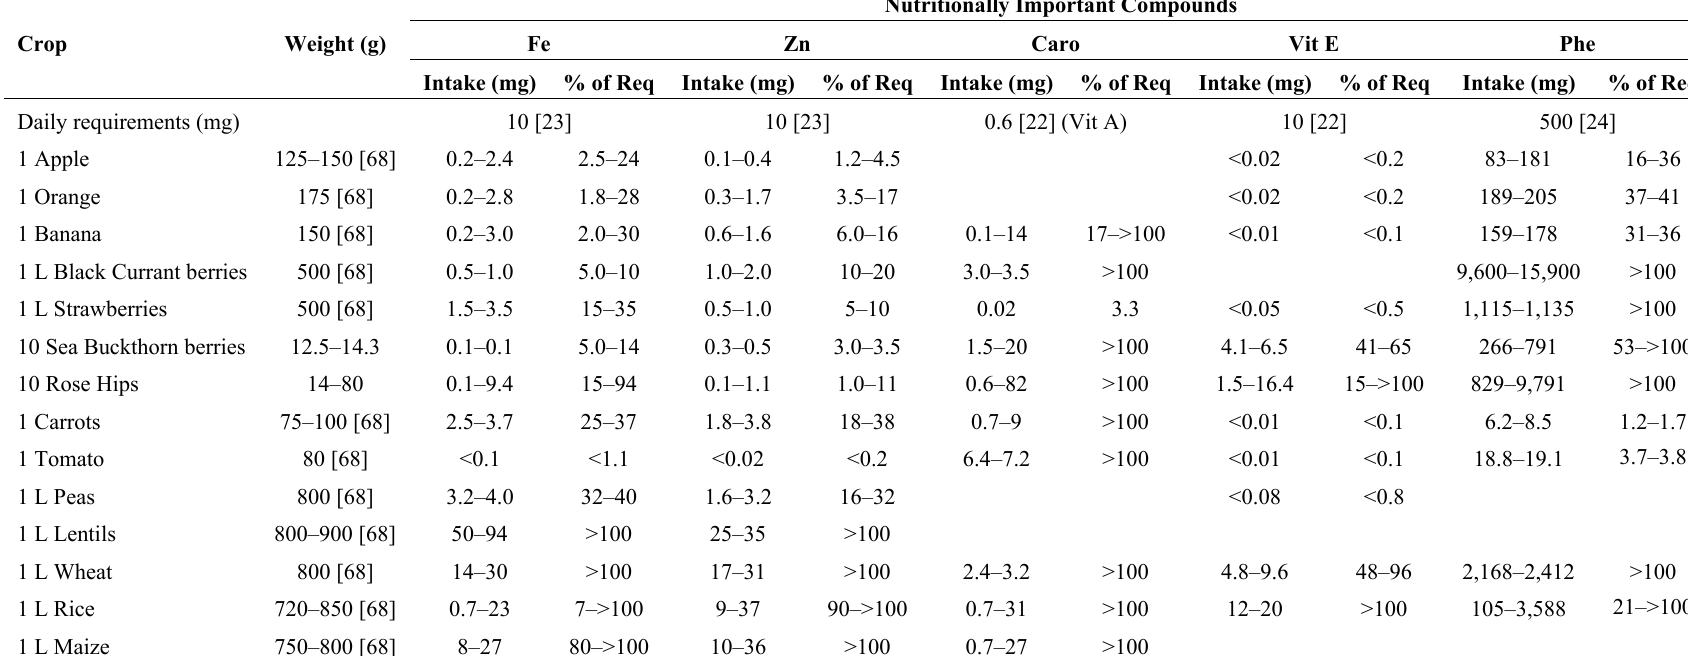
Table 2. Daily requirements of some nutritionally important compounds and examples of weight (g) of a certain amount of the various representative crops, and the resulting amount and relative amount in relation to daily requirements of the various nutritionally important compounds (Iron (Fe), Zinc (Zn), Total Carotenoids (Caro), Vitamin E (Vit E) and Total Phenolics (Phe)) from consumption of these weights of the crops.